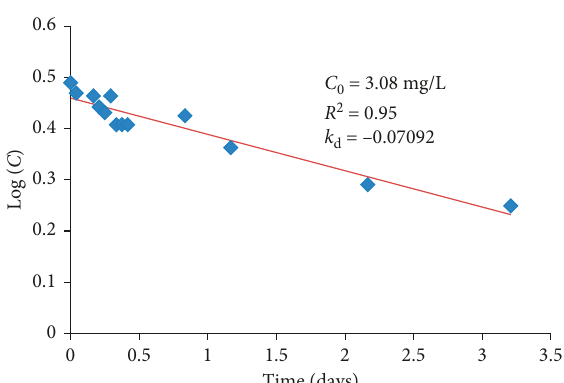
Figure 2: Linearised plot of chlorine residual with the initial chlorine dose of 3.08mg/L.